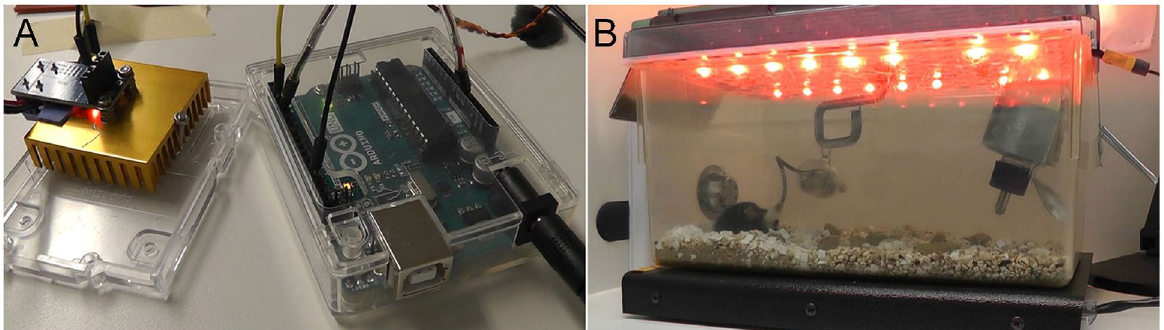
Figure 1. System for visual stimulation in freely moving mice. Arduino Uno and metal–oxide–semiconductor field-effect transistor (MOSFET) are used to generate square pulses of electric current ( A ) that power LED lamps mounted on the perforated aluminum plate at the top of a regular mouse cage ( B